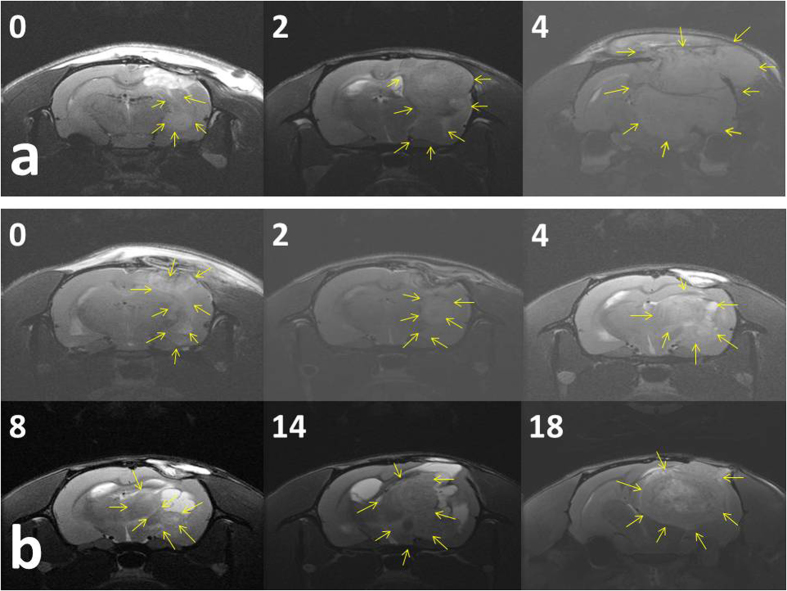
Serial rat brain MRI images of two rats.The number on the upper-left corner of each image indicates the number of weeks after nanofibrous membrane implantation. (a) The rat in the vehicle-treated group exhibited rapid tumor growth, leading to a severe mass effect. (b) The rat in the concurrent group evidenced temporary tumor stabilization; the tumor grew more slowly and reached the maximum tumor volume at 4 weeks; the tumor volume decreased between 4 and 8 weeks, and the tumor regrew progressively thereafter.